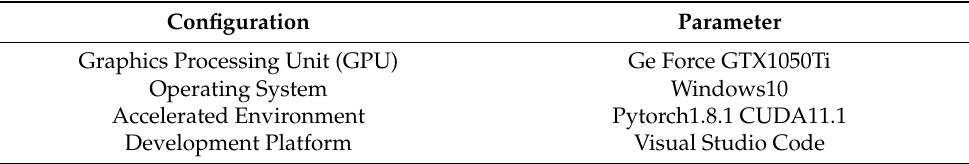
Table 2. Information about the test